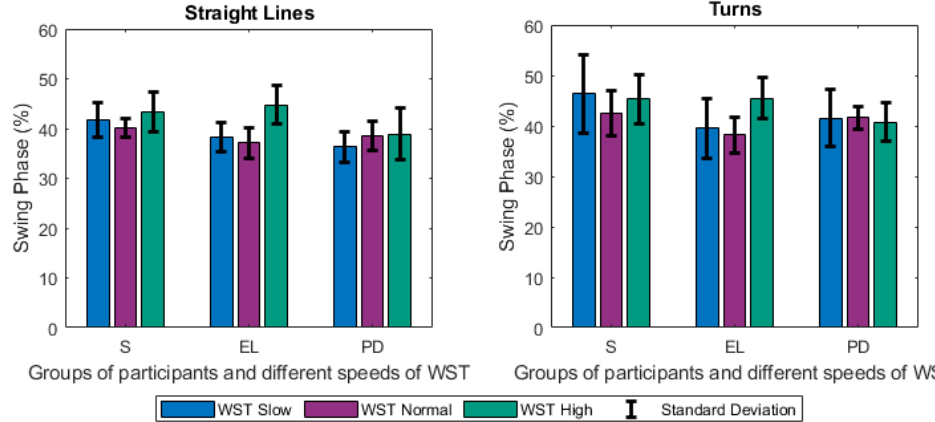
Figure 7. Changes of the Swing Phase (%) for Straight Lines and Turns (mean values along with standard deviations) between the different groups of participants (S, EL, PD) and the different speeds of the WST test (slow, normal, high).